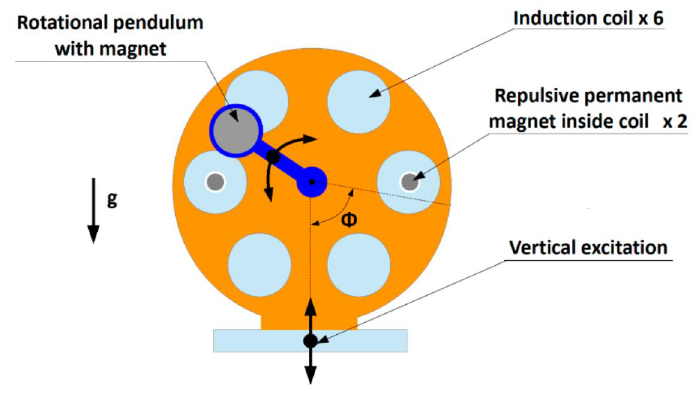
Figure 6. Pendulum-harvester schematic